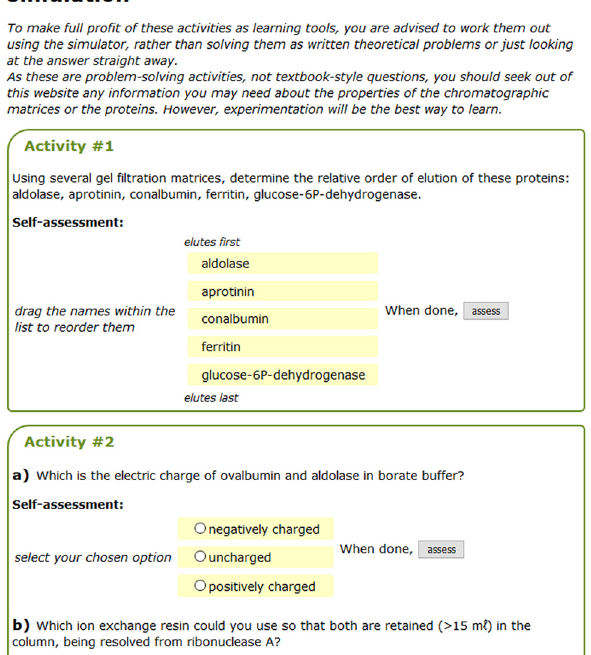
Figure 4: A partial view of activities designed to be solved using the simulation of column chromatography. Taken from ref. [6], Creative Commons BY-NC-SA